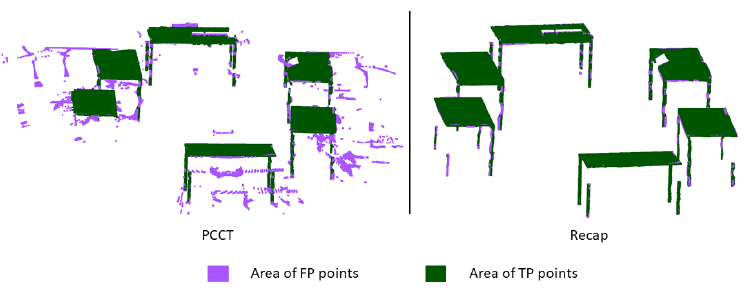
Figure 14. TP and FP points for the table class. The point cloud was semantically segmented with PCCT ( left ) and Recap ( right